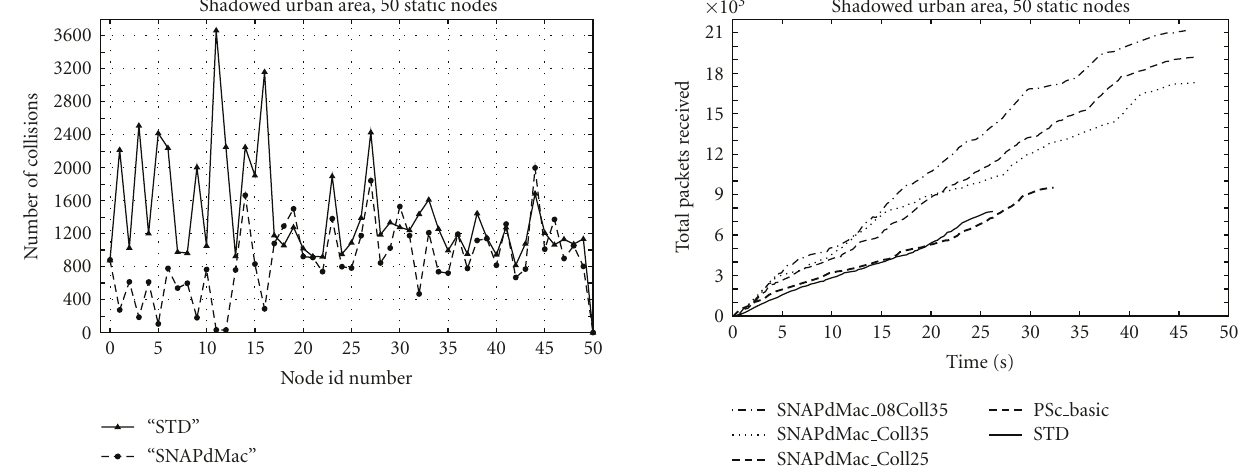
Figure 4: Number of collisions per node; static network. Figure 5: Total number of packets received versus time; static network.